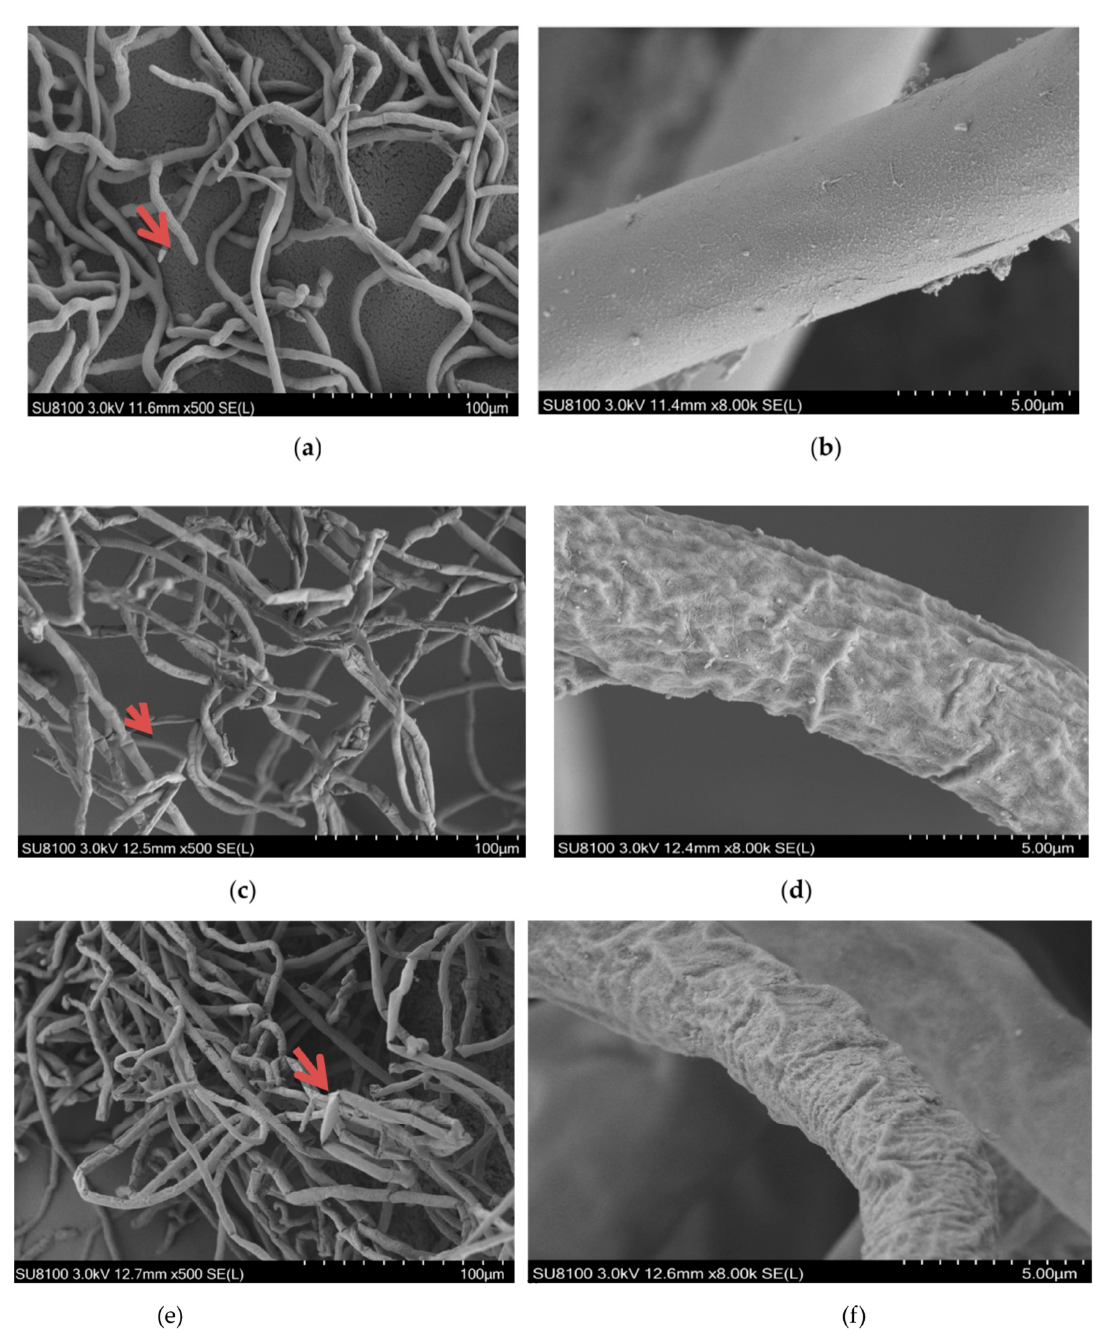
Figure 2. Scanning electron micrographs (SEM) of R. solani : hyphae exposed to the ethanol extracts from two R. solani at concentrations of ( a , b ) 0 μ g/mL and ( c , d ) EC 75 = 36.34 μ g/mL; the ethanol extracts from clove, ( e , f ) EC 75 = 72.59 μ g/mL; the ethanol extracts from gallnut. Arrows and arrowheads indicate hyphae shrinkage and partial distortion.